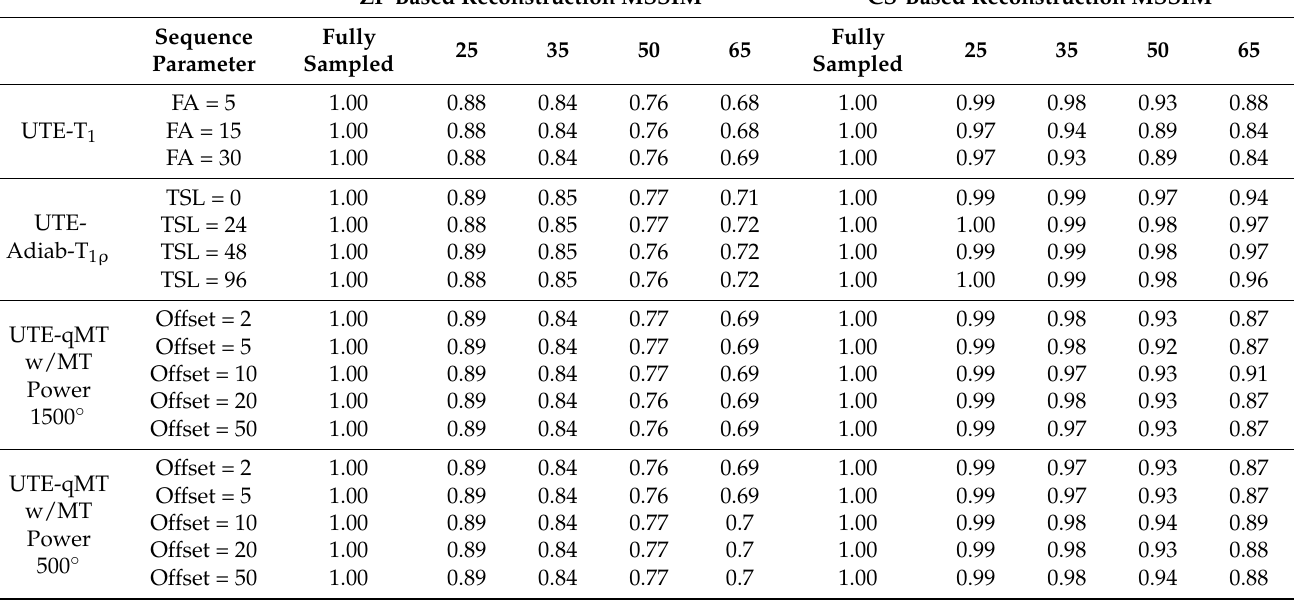
Table 2. This comparison of zero-filled (ZF) and CS reconstruction using MSSIM measure at various undersampling rates. MSSIM values for various flip angles of UTE-T 1 show that with increase in undersampling rate, MSSIM falls below 0.9 for CS images and much lower value (~0.7) for ZF-re-